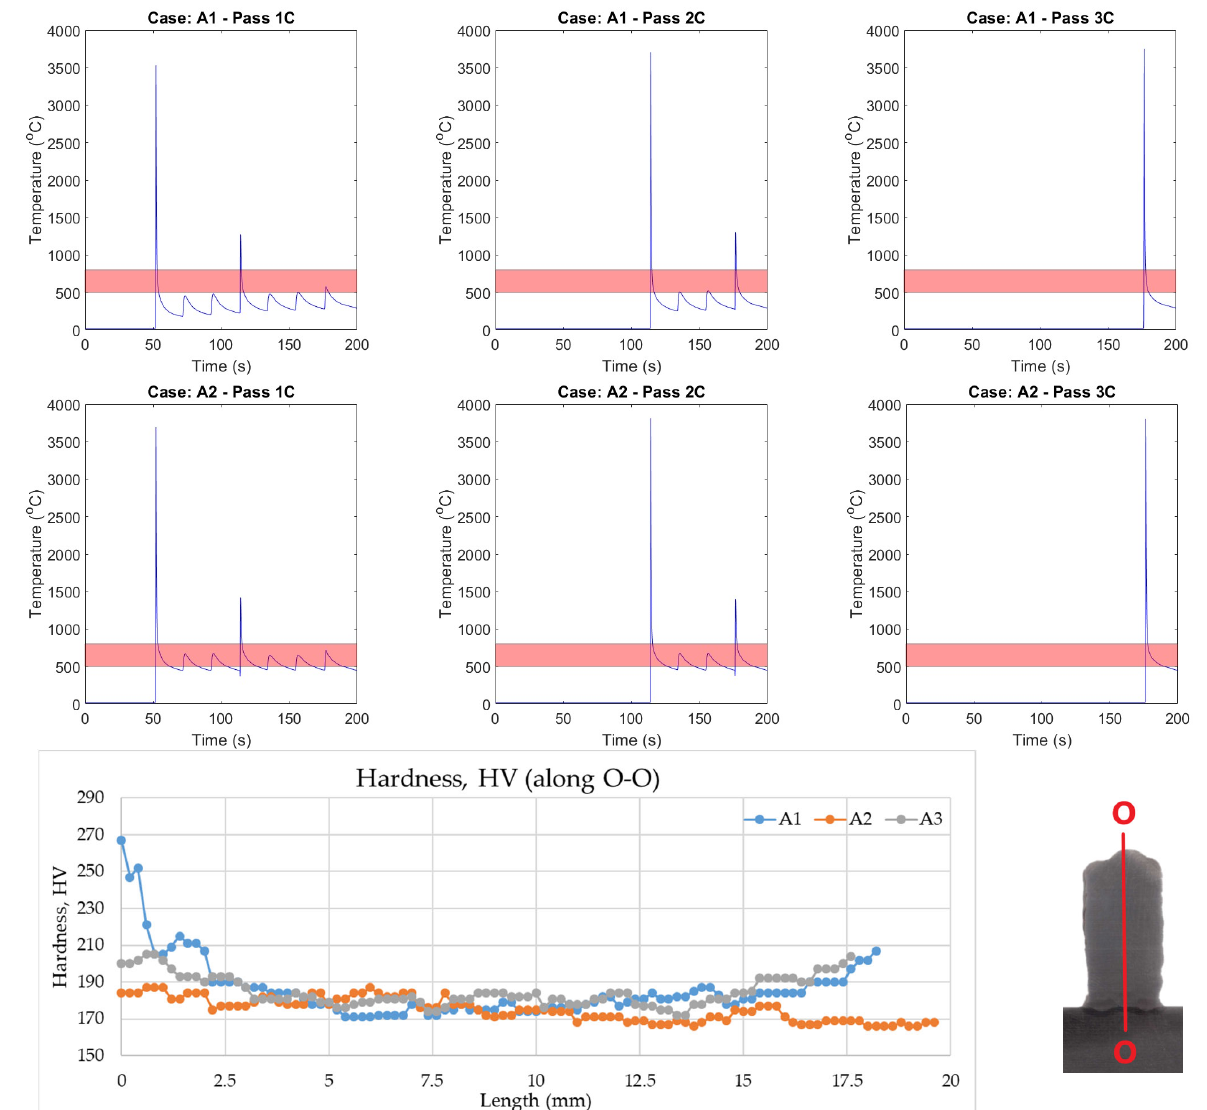
Figure 17. T8/5 comparison of cases A1 and A2 for middle passes and hardness along the centerline.